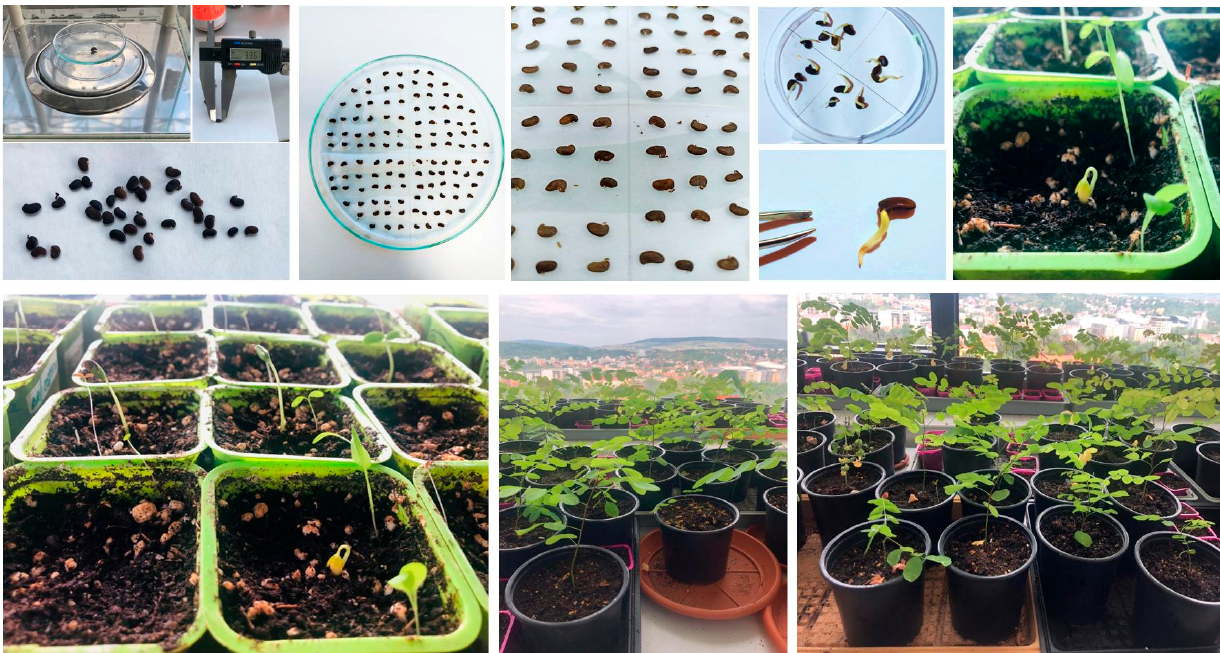
Figure 2. Stages of analysis of seed morphological characteristics, seed germination and seedling growth.